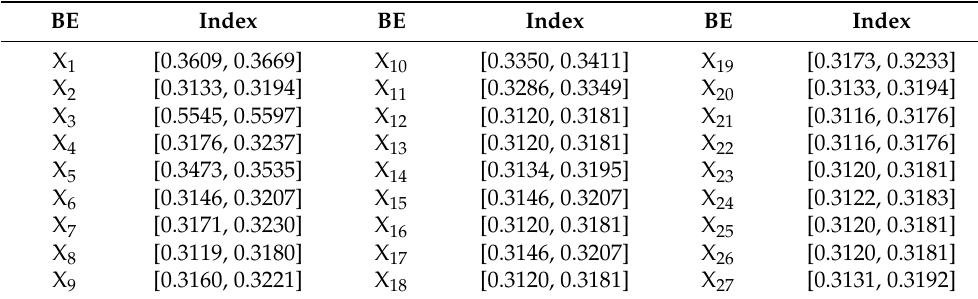
Table 15. Probability importance of each BE.